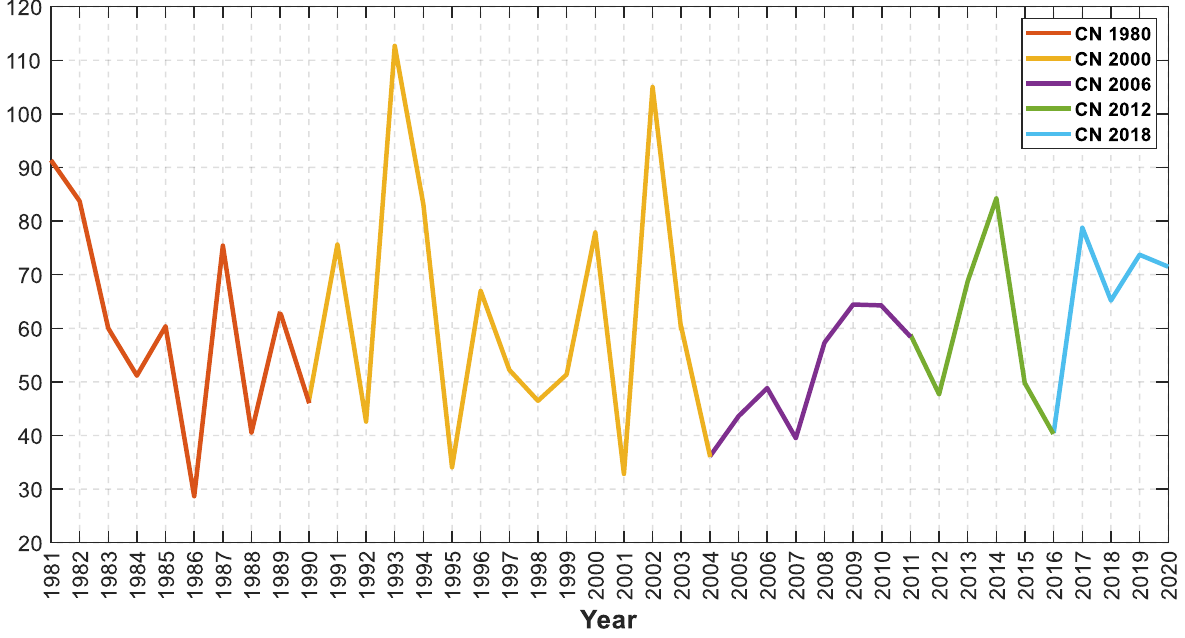
Figure 14. Number of annual exceedances (1999–2020) of the first hydrometric level threshold over the Seveso River basin for Paderno Dugnano ( a ) and Cantù ( b ) gauge sections, respectively. To statistically define if the presence or not of a significant trend exists, we calculated it through the Cox–Stuart test. As mentioned above in Section 3, as the available data se- ries has here less than 30 values, we preferred to not use the MK test as before. However, both the obtained p -values are 0.344 and 0.508 for Paderno Dugnano and Cantù, respec- tively, which are below the α = 5% threshold; this again confirms the absence of a trend with the null hypothesis H 0 accepted.